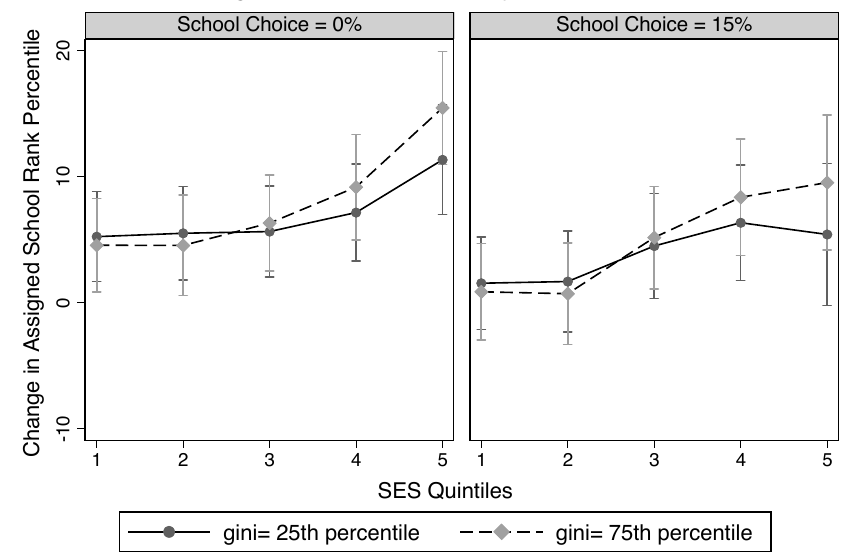
Figure 2: Model predictions of assigned-school test-score rank mobility among families who move within commuting zones at the 10th and 90th percentiles of income inequality, with all control variables being held at their means (top panel) and when including an interaction between family SES and percent school choice (bottom